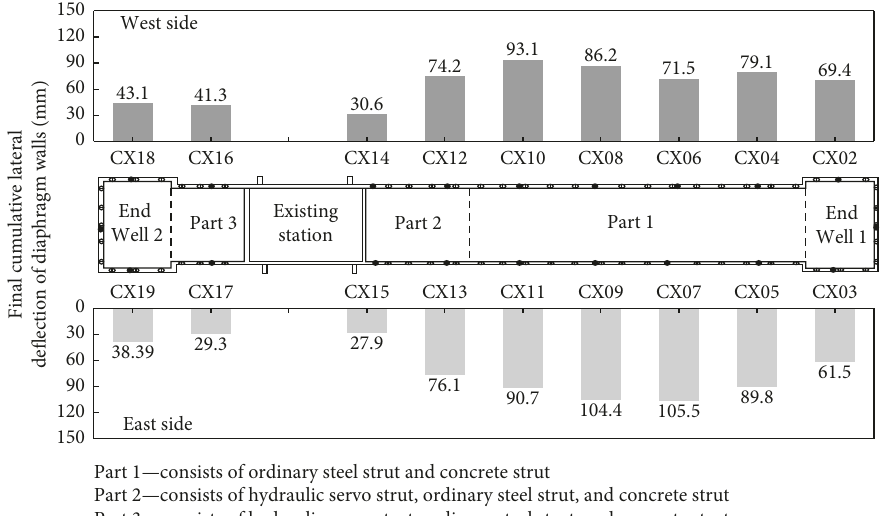
Figure 12: Final cumulative lateral deflection of the diaphragm walls around the foundation pit.